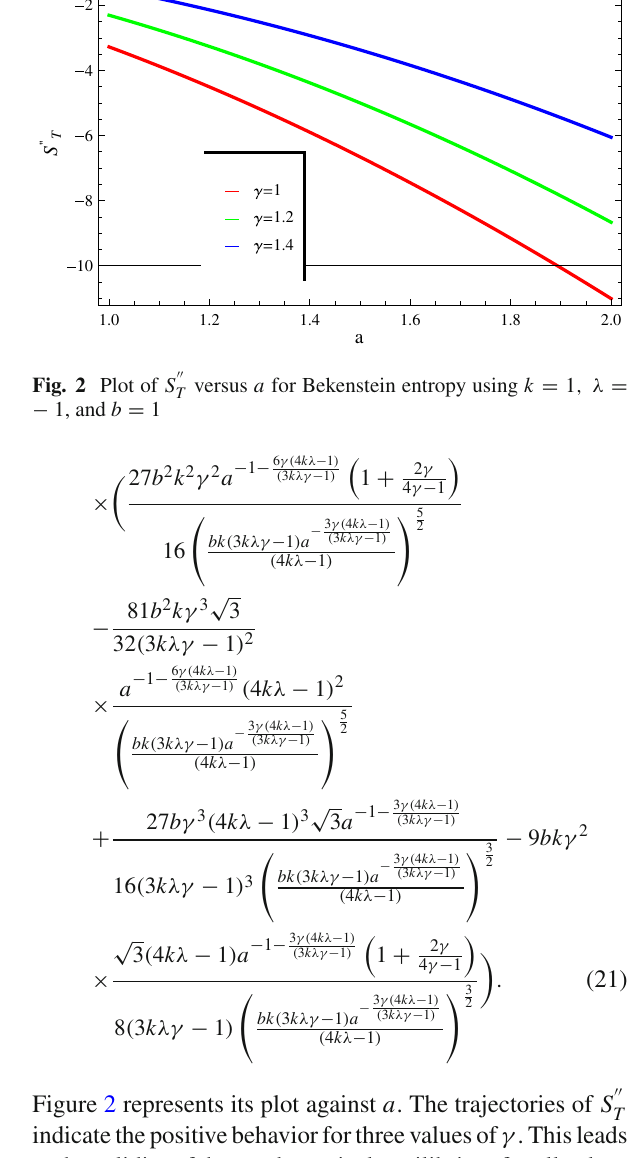
Figure 2 represents its plot against a . The trajectories of S indicate the positive behavior for three values of γ . This leads to the validity of thermodynamical equilibrium for all values of γ